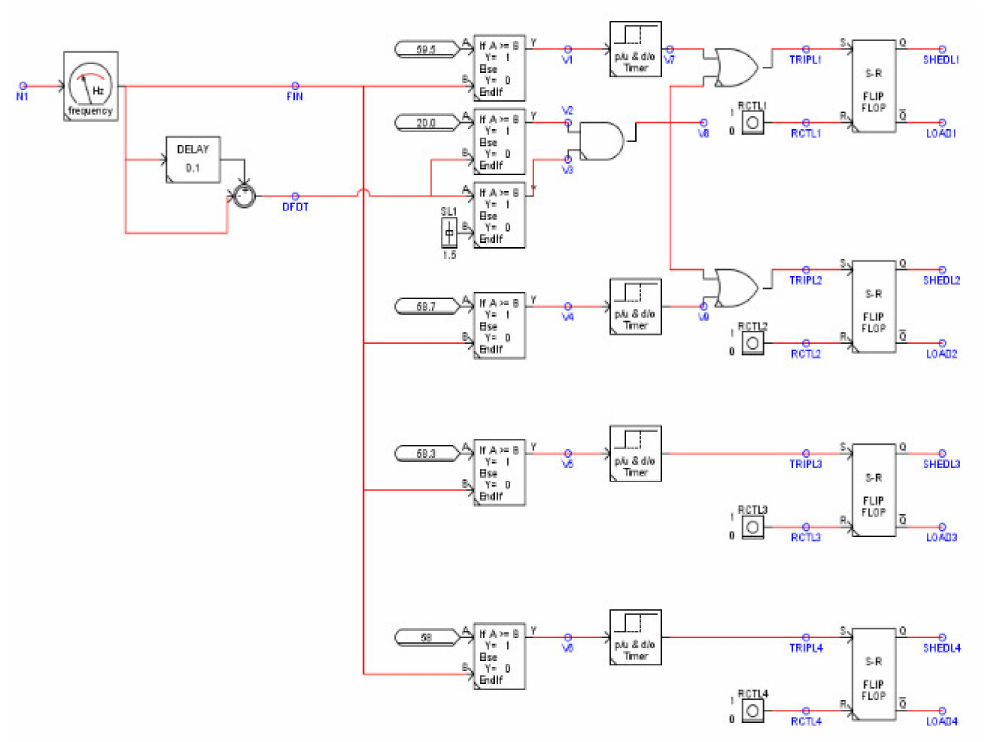
Figure 8. Load shedding logic implemented in real time digital simulator